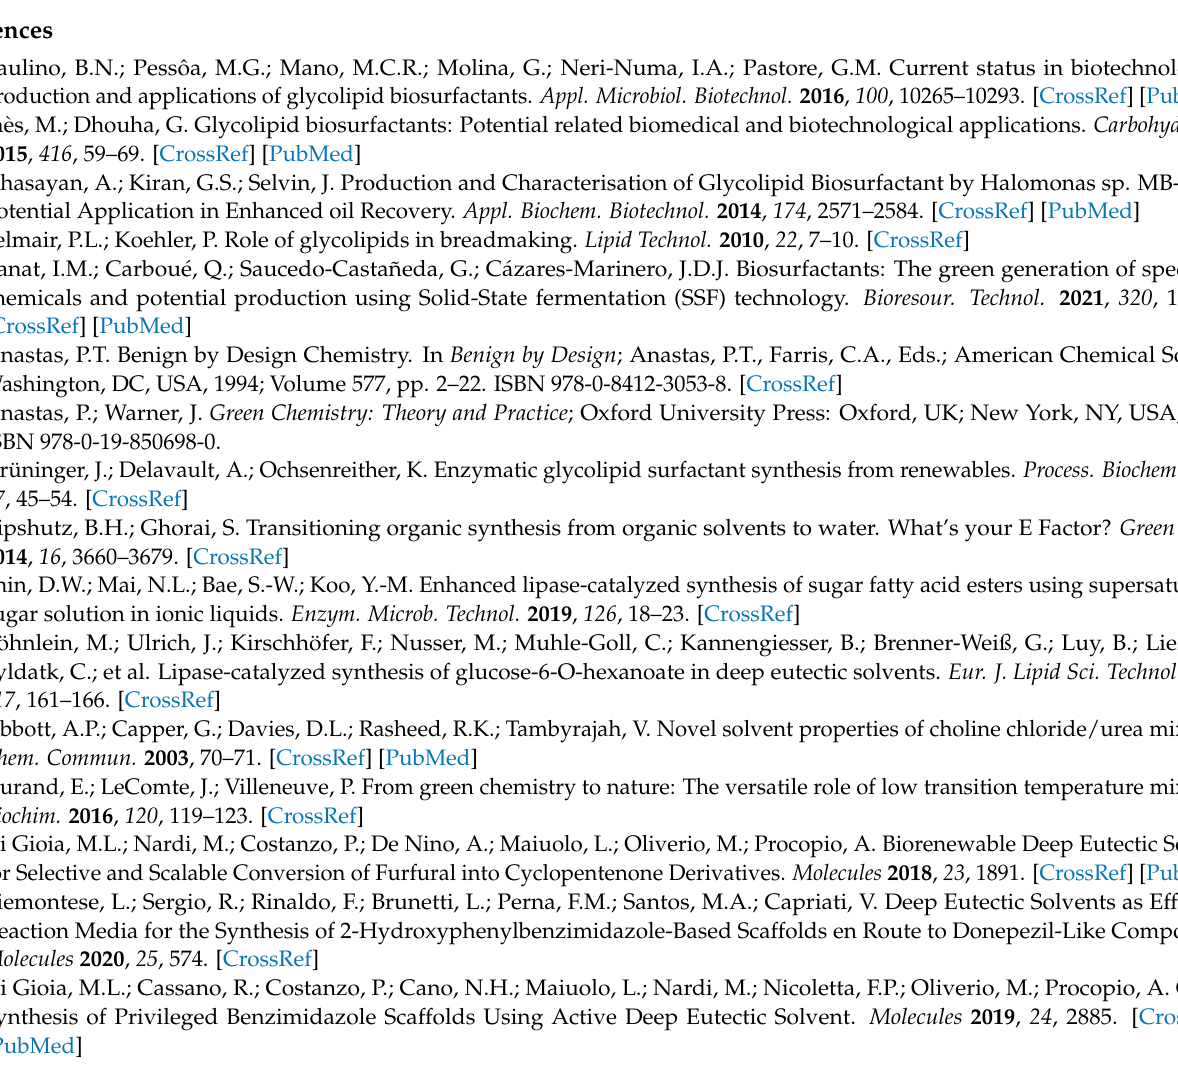
Figure A1. Extracted NMR signals of ( A ) C 4 H and ( B ) C 3 H of the sorbitol.